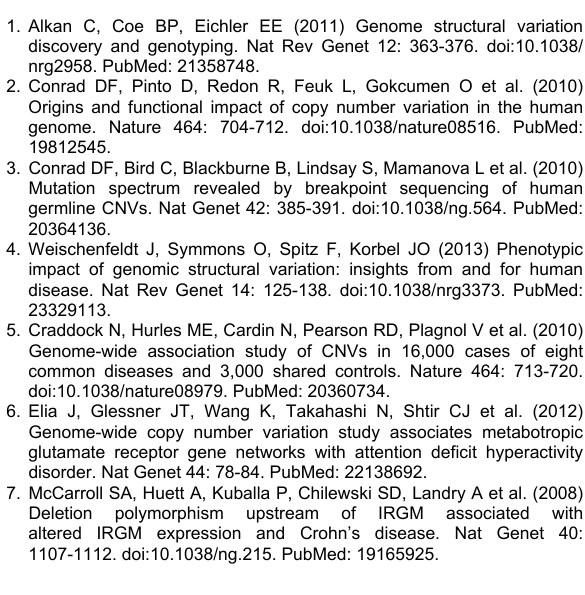
Figure S1. Pattern of linkage disequilibrium (LD) for the HapMap CEU population. SNPs used to characterize the deletions in KLK15 and KLK9 with a frequency in the HapMap CEU population were used. LD is estimated and given as D'. Low LOD (<2) and low D' (<1) are shown in white, low LOD and perfect D' (1) are shown in blue, high LOD (#2) and low D' are shown in shades of pink/red and high LOD and perfect D' are shown in bright red. Positions of SNPs are given relative to the deletions in KLK15 and KLK9 . The filled arrows indicate the positions of the deleted regions, the deleted region in KLK15 in-between marker rs3212810 and rs3745523 and the deleted region in KLK9 in-between markers rs1612902 and rs952109. Table S1. Patient characteristics by biopsy outcome. All values are median (IQR) or frequency (percent). Table S2. SNP markers in the kallikrein gene locus analyzed in this study. (A) SNPs used in the first screening for deletions in the kallikrein locus. (B) SNPs used in haplotyping of the identified deletions.